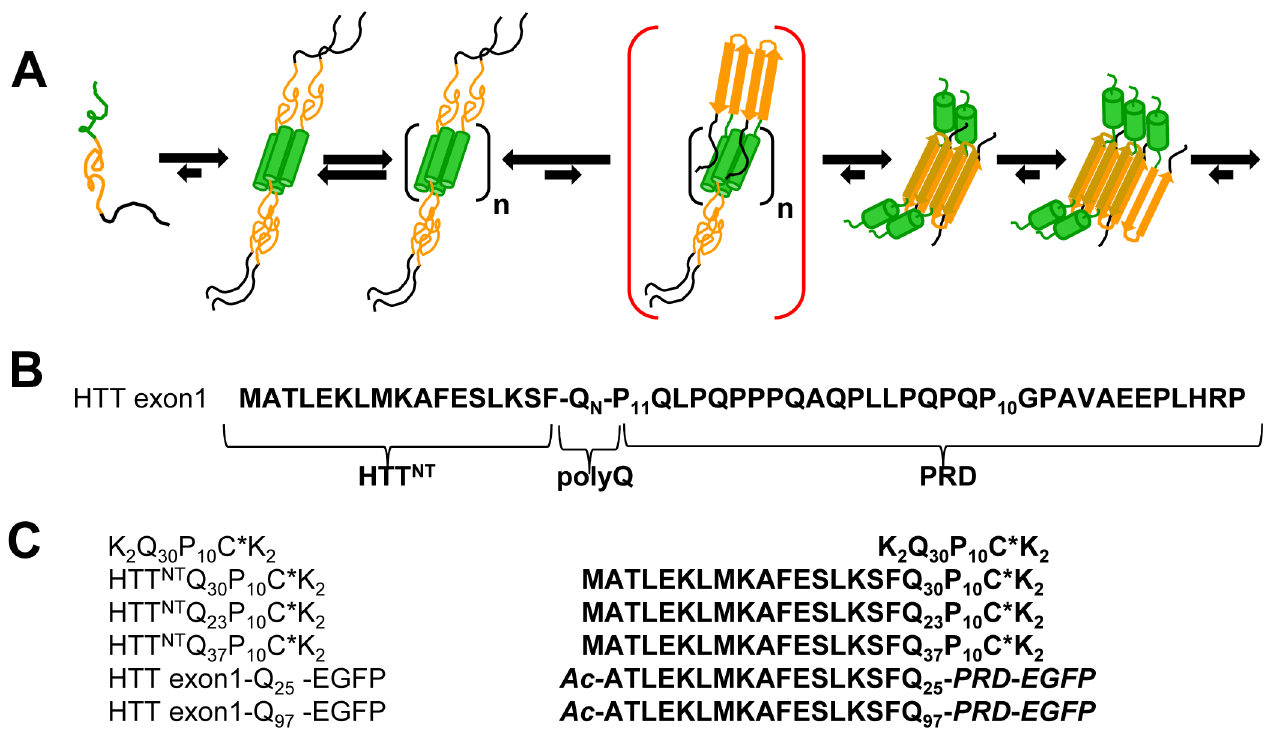
Fig 1. Structures and assembly mechanism of HTT exon1 polypeptides. A. Previously proposed mechanism of amyloid nucleation (HTT NT , green; polyQ, orange; PRD, black). B. Sequence of HTT exon1. C. Sequences of peptides studied. C * = Cys residue modified with Alexa Fluor 555 (see Materials and